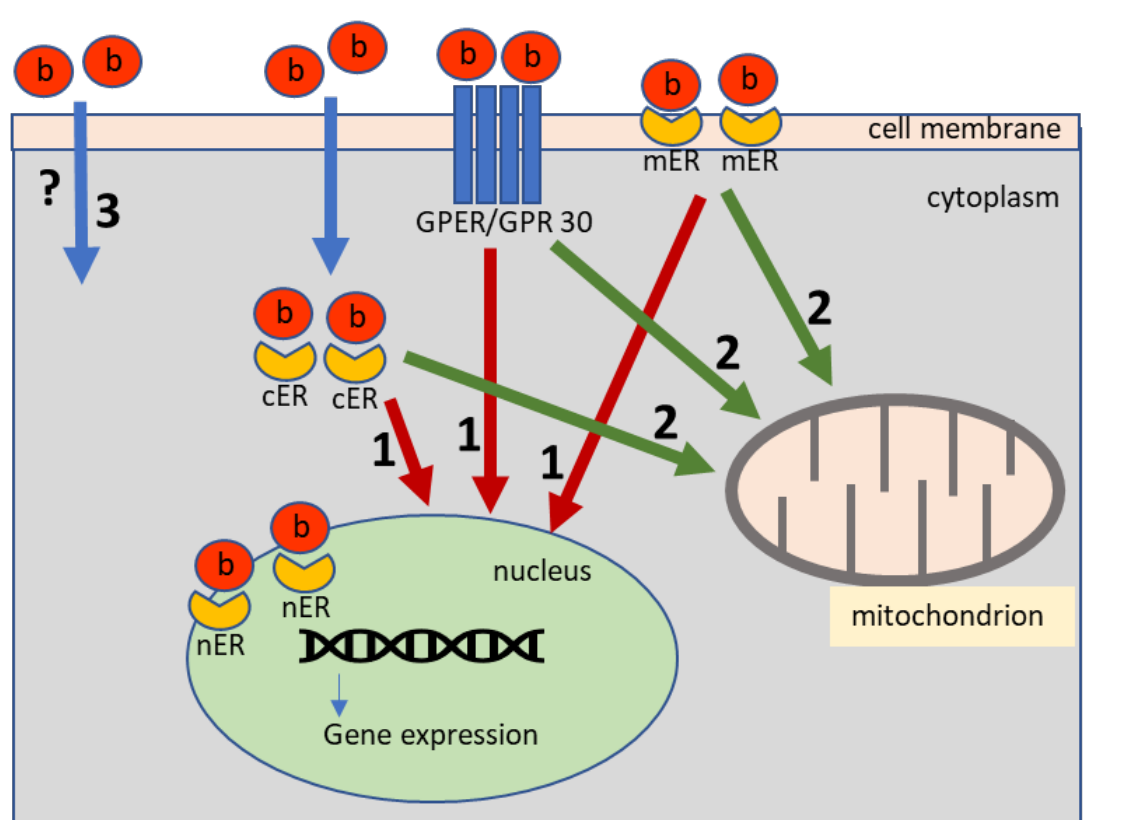
Figure 2. The pathways of bisphenols impact on the cell: (1) genomic estrogenic pathway; (2) non-genomic estrogenic pathway; (3) possible estrogenic independent pathway; b—bisphenols; cER—cytoplasmic estrogen receptors; mER—membrane estrogen receptors; nER—nuclear estrogen receptors; GPER/GPR 30—G protein-coupled estrogen receptor